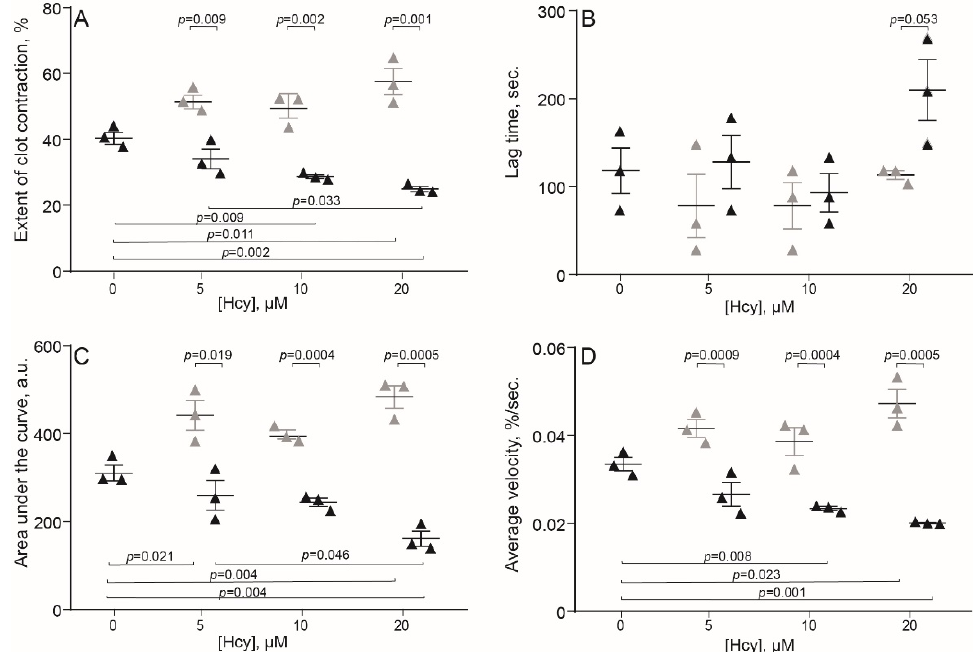
Figure 2. Parameters of clot contraction in clots made from the blood of control rats without and with addition of exogenous Hcy in vitro ( n = 3). Grey triangles: 1-min pre-incubation with Hcy; black triangles: 15-min pre-incubation with Hcy before initiation of the clot contraction assay. Parameters analyzed: extent of contraction ( A ); lag time ( B ); area under the contraction kinetic curve—work done by platelets ( C ); average contraction velocity ( D ). Mean ± SEM, repeated measures ANOVA, post-hoc Tukey’s test. Only significant differences are shown ( p < 0.05).